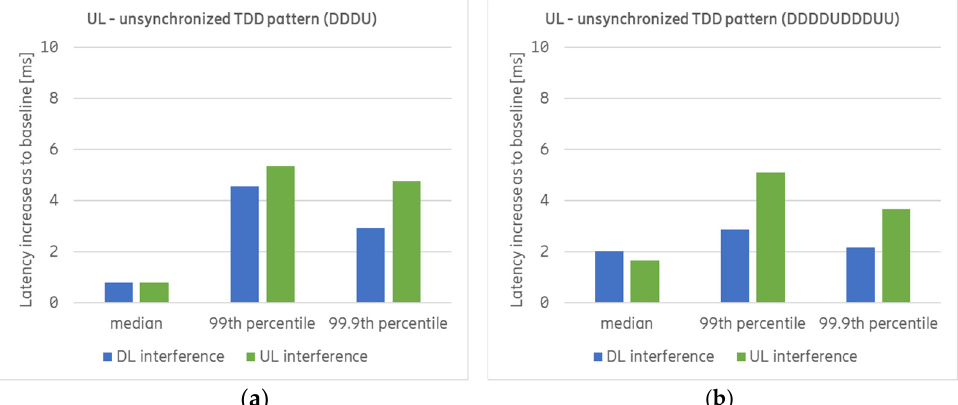
Figure 6. Increase in UL latency compared to its baseline for unsynchronized TDD pattern. ( a ) Indoor TDD pattern DDDU while outdoors DDDDU are configured. ( b ) Indoor TDD pattern DDDDUDDDUU and outdoor DDDDU are configured.